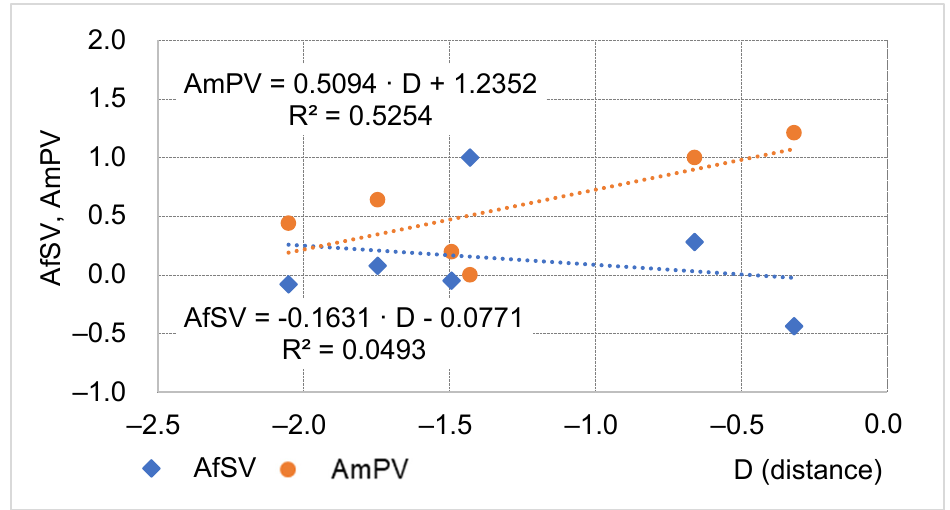
Figure 16. Relationship between AmPV and AfSV, depending on distance from sultriness curve.